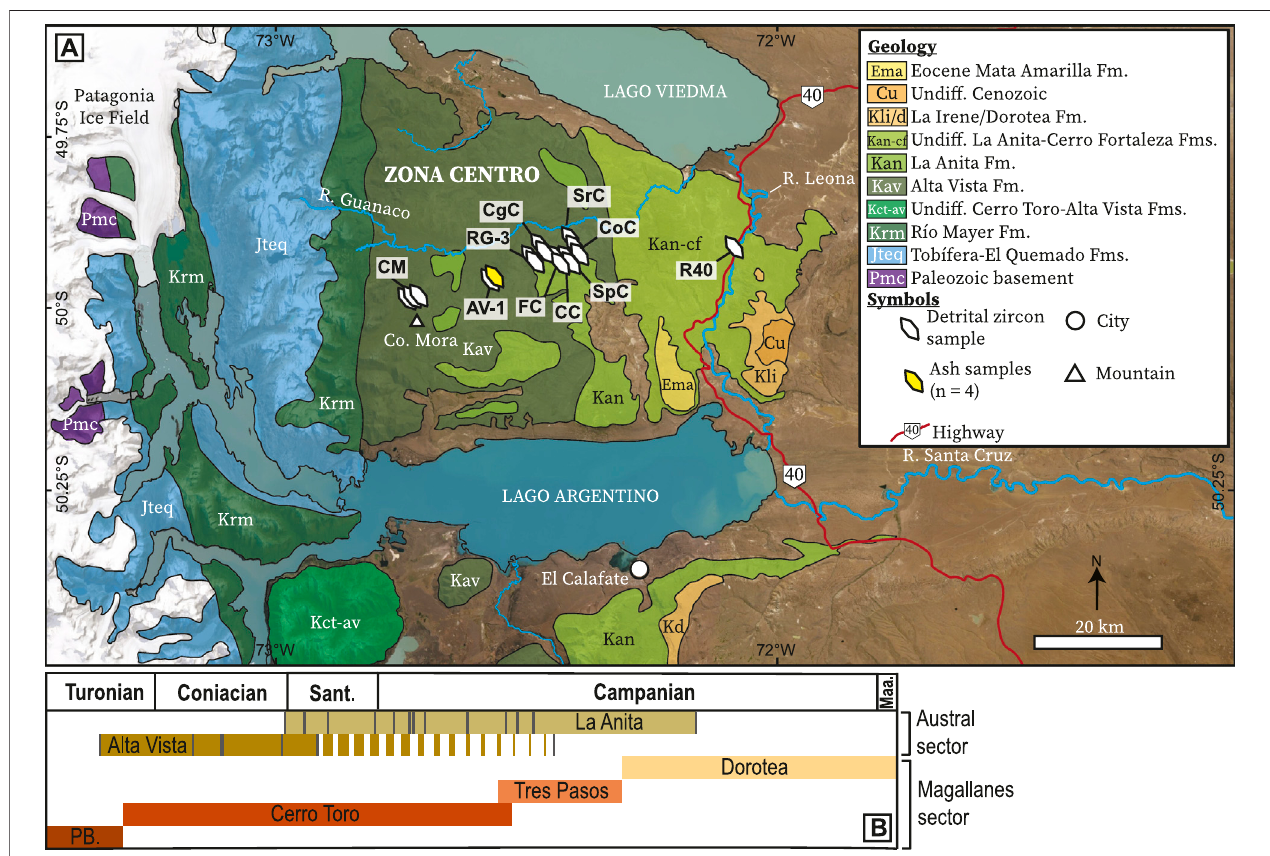
FIGURE 3 | (A) Geologic map of the Zona Centro region, modi fi ed after Ghiglione et al. (2014) and Sickmann et al. (2018); Sickmann et al. (2019). Stratigraphic sections are labeled ( Figure 4 ). (B) Chronostratigraphic age correlation between Austral (Alta Vista and La Anita Formations) strata from this study and units from the MagallanessectorcompiledbyDanielsetal.(2019).AltaVistaFormationlinebecomesdashedasthelateSantonianthroughCampanianagerangeisde fi nedbyasingle middle Campanian maximum depositional age. The rest of the ash and sandstone ages range between the Turonian and Santonian for the Alta Vista Formation. Gray vertical lines on the Alta Vista and La Anita Formation rectangles highlight maximum depositional ages from individual samples. PB, Punta Barrosa Formation.